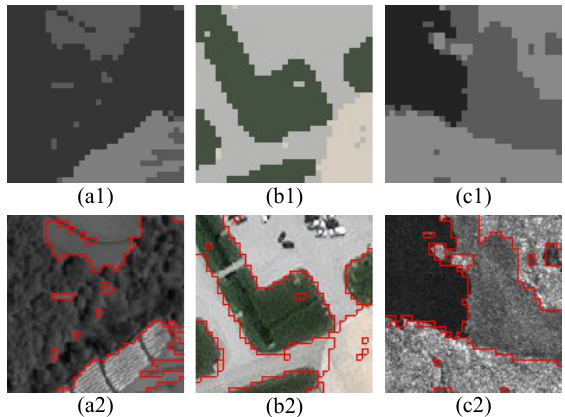
Figure 5. Segmentation results of remote sensing images with the proposed